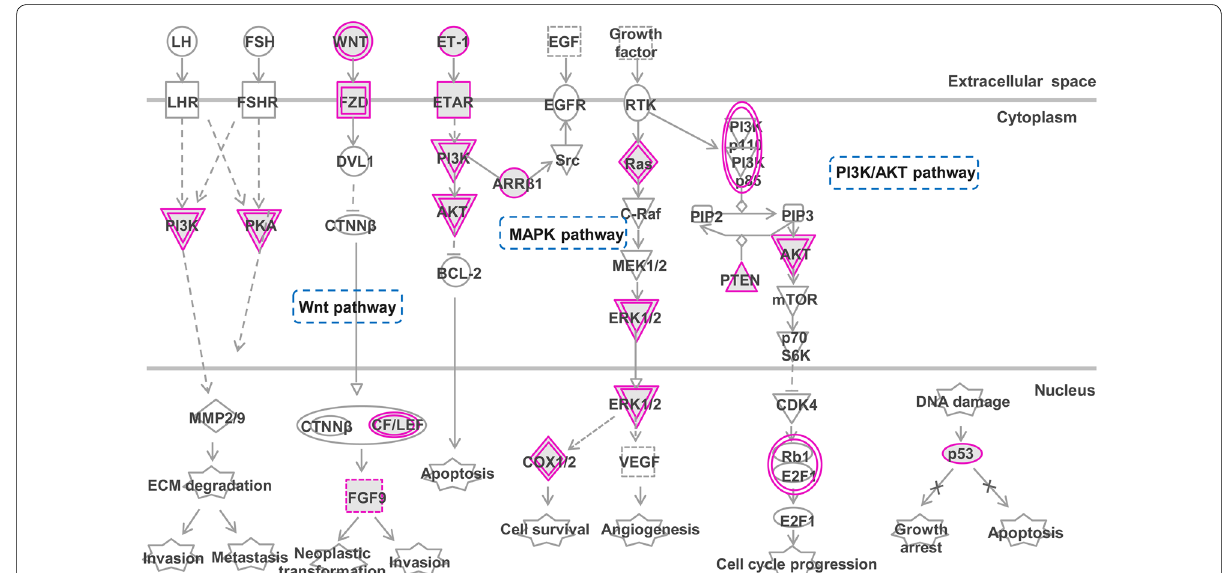
Fig. 5 The ovarian cancer pathway enriched by target genes of the identified miRNA biomarkers in IPA. Objects with purple circles or triangles are acting locus by mapped